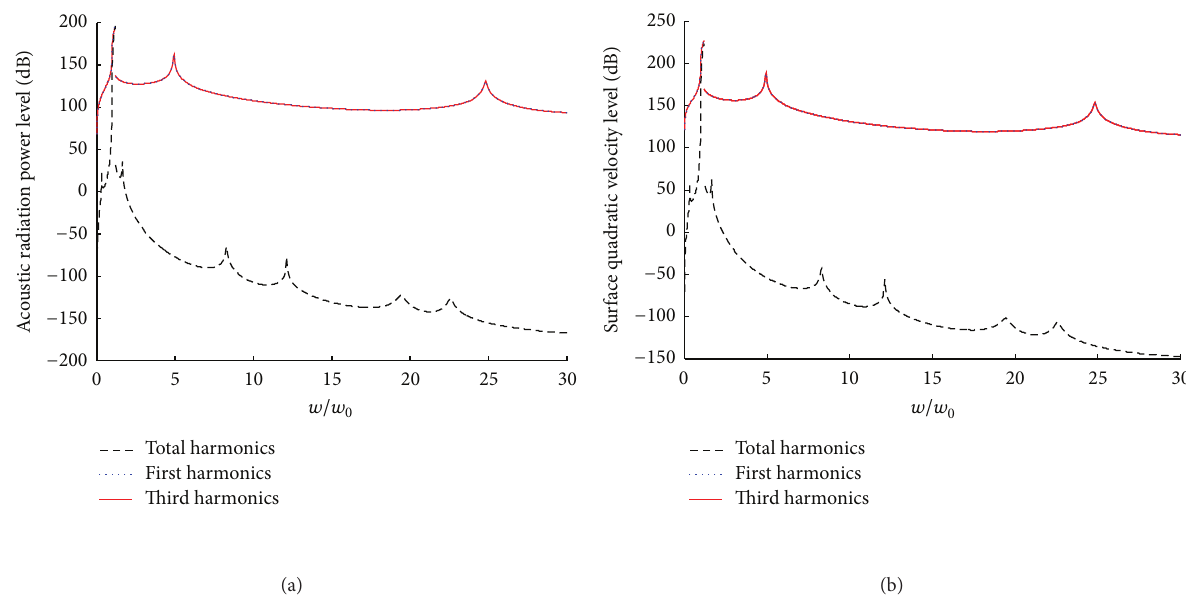
Figure 3: Influence of harmonic components on the vibroacoustic properties of the plate ( 𝑘 3 = 10𝑘 1 ): (a) acoustic radiation power level and (b) surface quadratic velocity level.